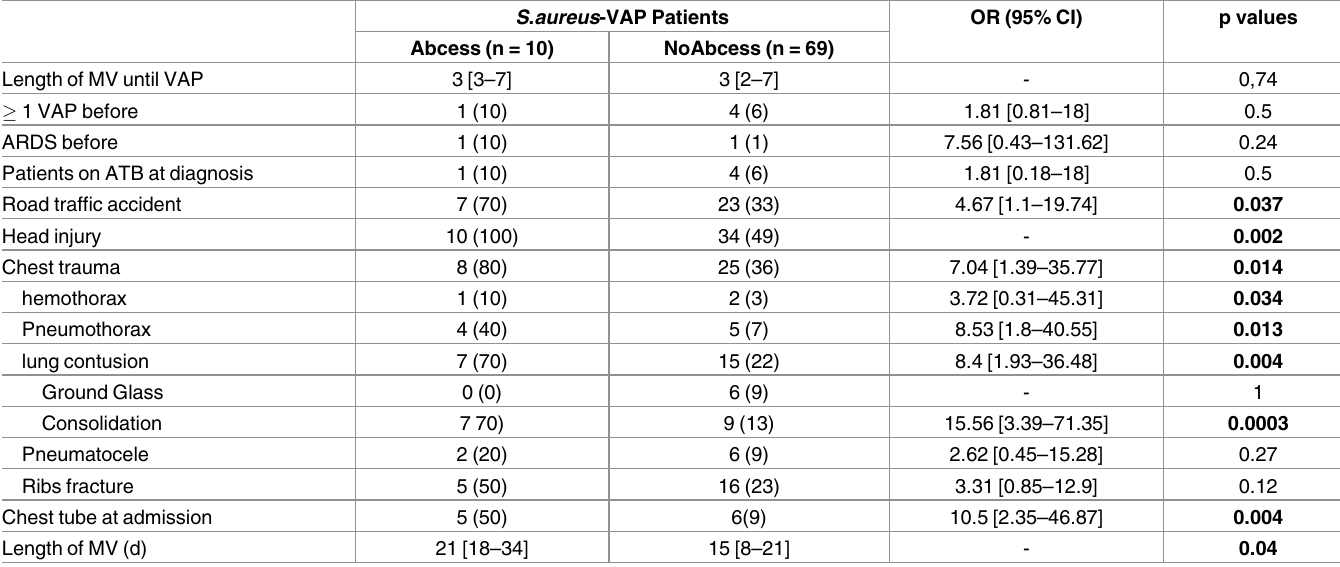
Table 2. Host risk factors for abscess